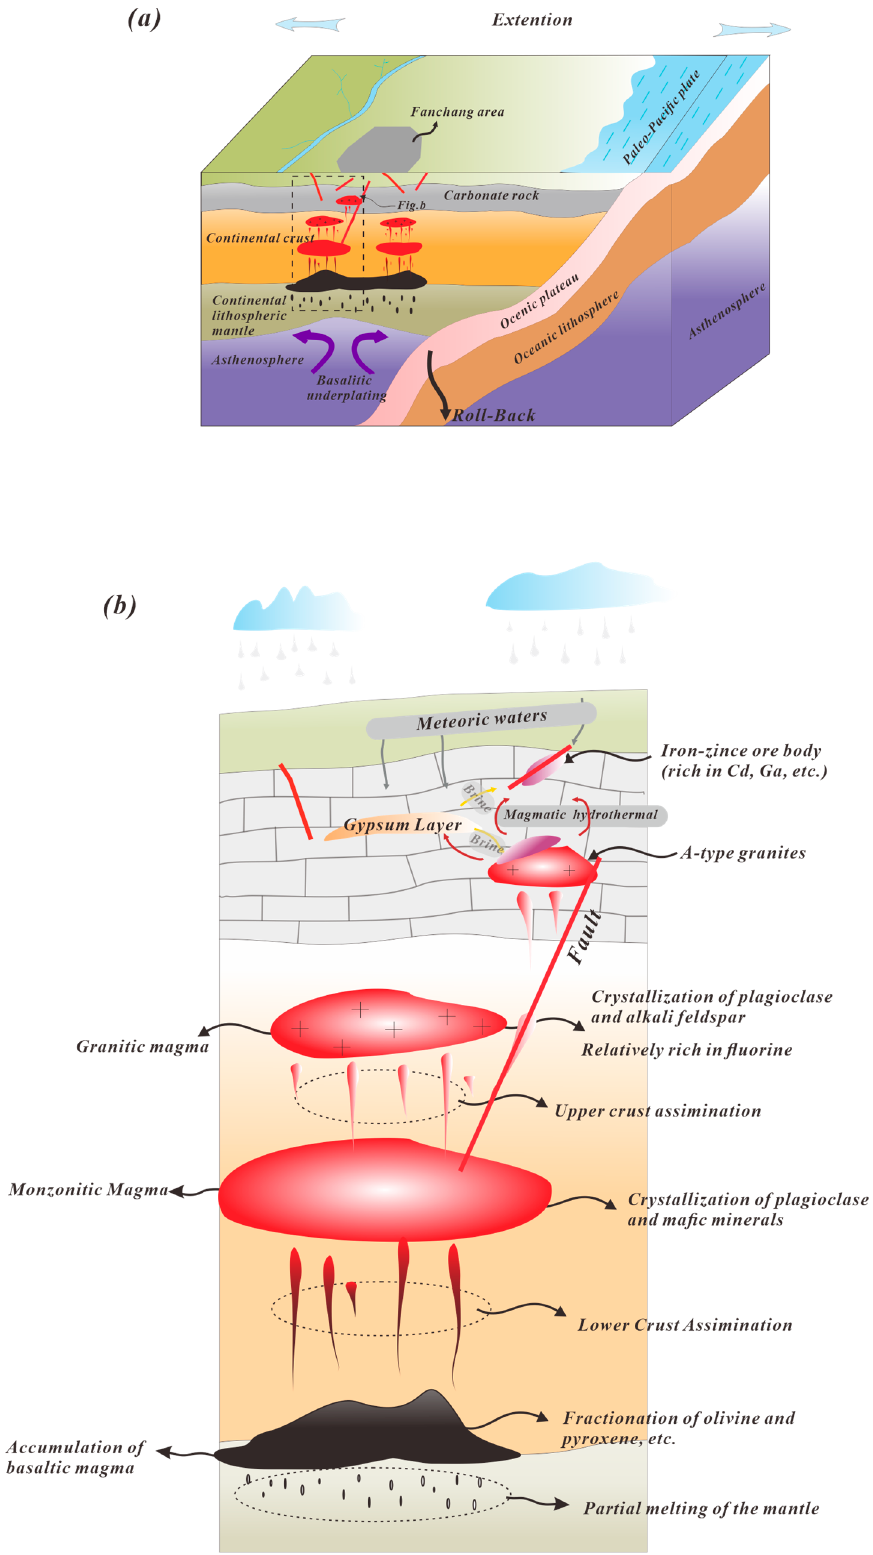
Figure 19. ( a ). Regional geotectonic model for the Triassic A-type granitic magmatism in the FVB and the MLYMB. ( b ). A more detailed petrogenetic and metallogenetic model for A-type magmatism and related ore formation in the FVB.